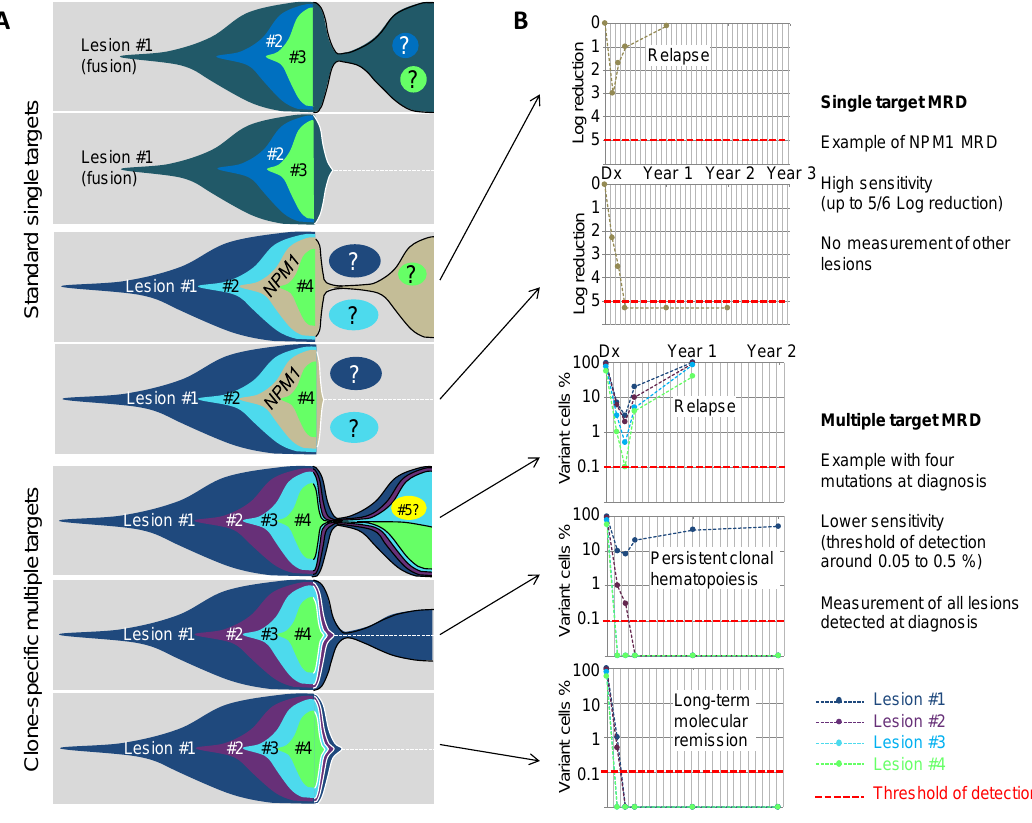
Figure 3. Molecular MRD using single and multiple targets to track AML clones. ( A ) Fish diagrams showing clonal evolution in AMLs with various combinations of lesions and outcomes. MRD Target lesions are indicated by contoured areas in the right part (post-diagnosis) of the diagrams. Black contours indicate lesions that are found MRD-positive, and white contours and dotted lines indicate lesions that become progressively not detectable. Circles with question marks indicate lesions that are not detected by the MRD test. ( B ) Simulations of MRD monitoring of five cases from (A) using a single target MRD test (upper panels) or a clone-specific, multi-target MRD approach (lower panels). Red lines indicate the theoretical sensitivity of the assay. #1, #2, #3 etc. indicate the successive genetic lesions.